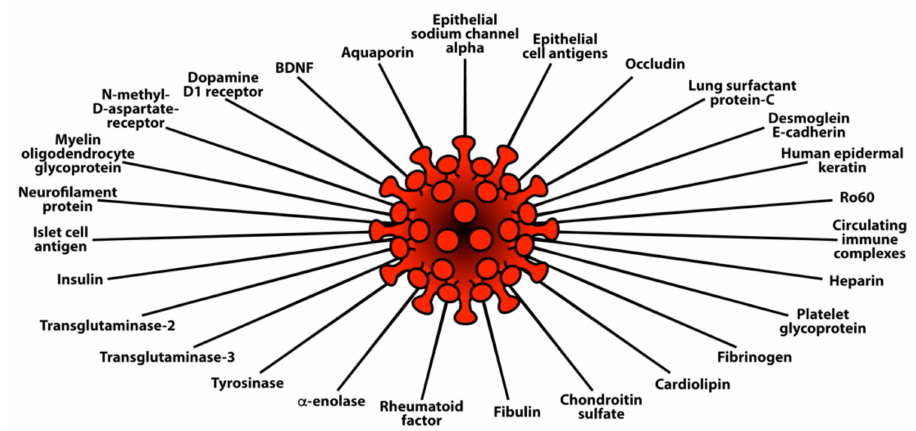
Figure 6. Elevations in IgG antibody against 27 different human tissue antigens in the blood of patients with mild to severe SARS-CoV-2 infection (positive for PCR and antibody) in comparison to healthy